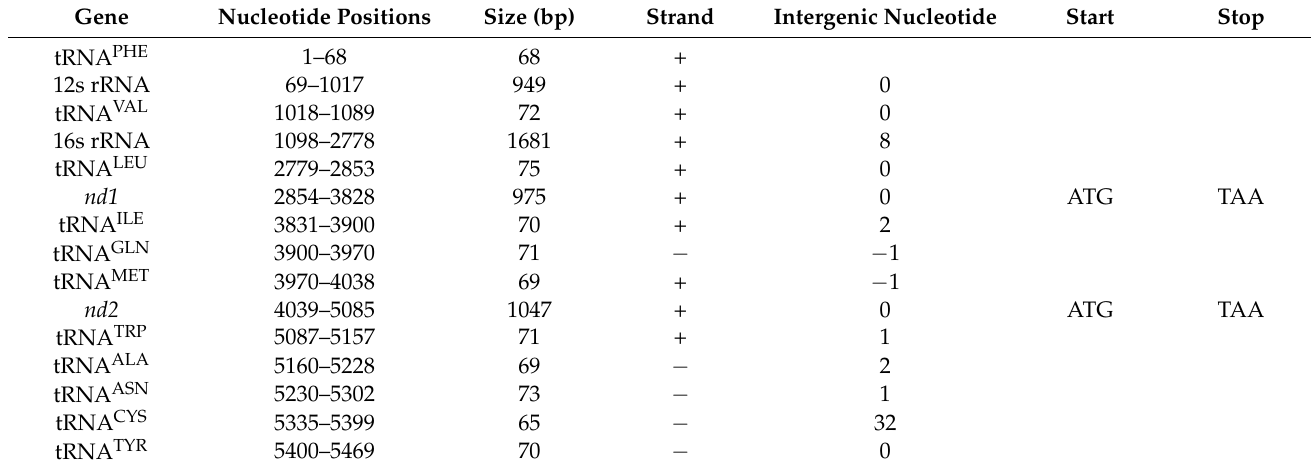
Table 3. Characteristics of the mitochondrial genome of Rhinogobius shennongensis